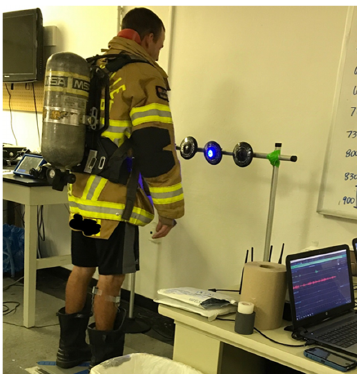
Figure 1. Professional firefighter performing the eyes open dual-task (EOT) cognitive task standing on a force plate measuring postural stability and with electromyography measuring muscle activation of lower extremity muscles.